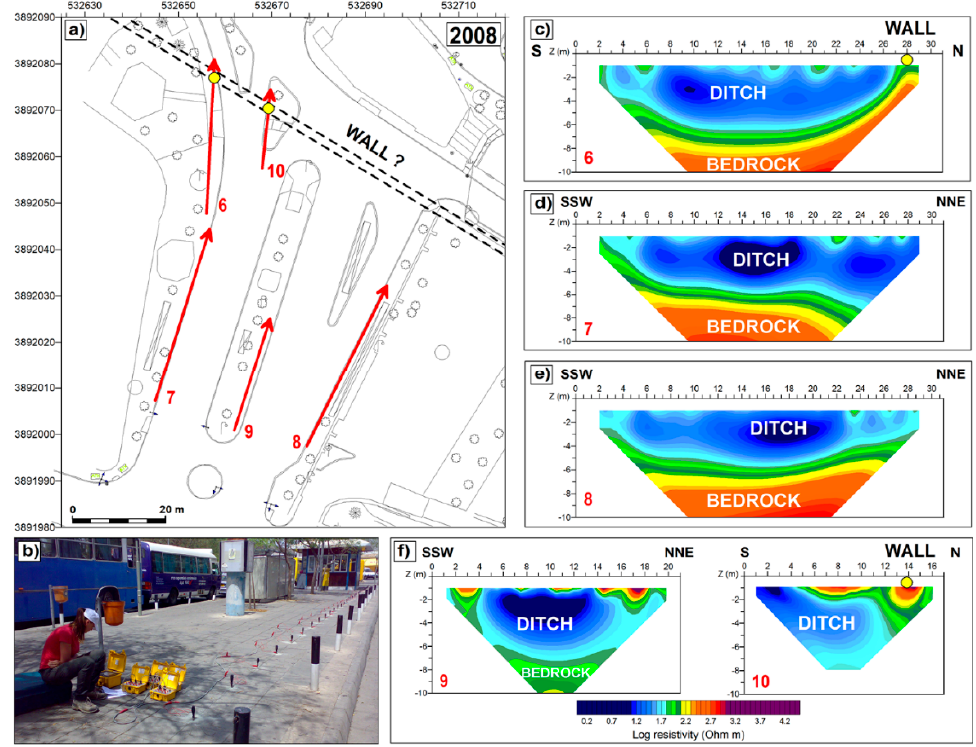
Figure 8. Solomon Square: location of ERT profiles 6–10 ( a ), data acquisition ( b ) and geophysical results ( c – f ).